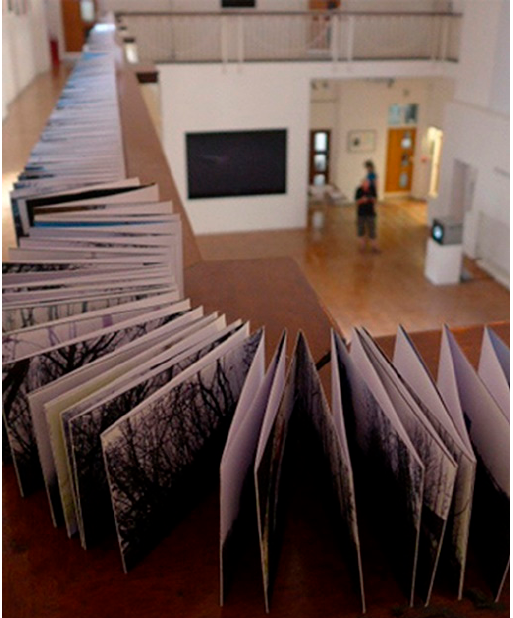
Figure 5. The Author, The M25 in 4000 Images (2014). Inkjet on matte paper, cut, folded, and constructed by hand. Edition of 1. Detail. From the Exhibition RE:PRINT/RE:Present , Ruskin Gallery, Cambridge 2015. Photo: The Author.